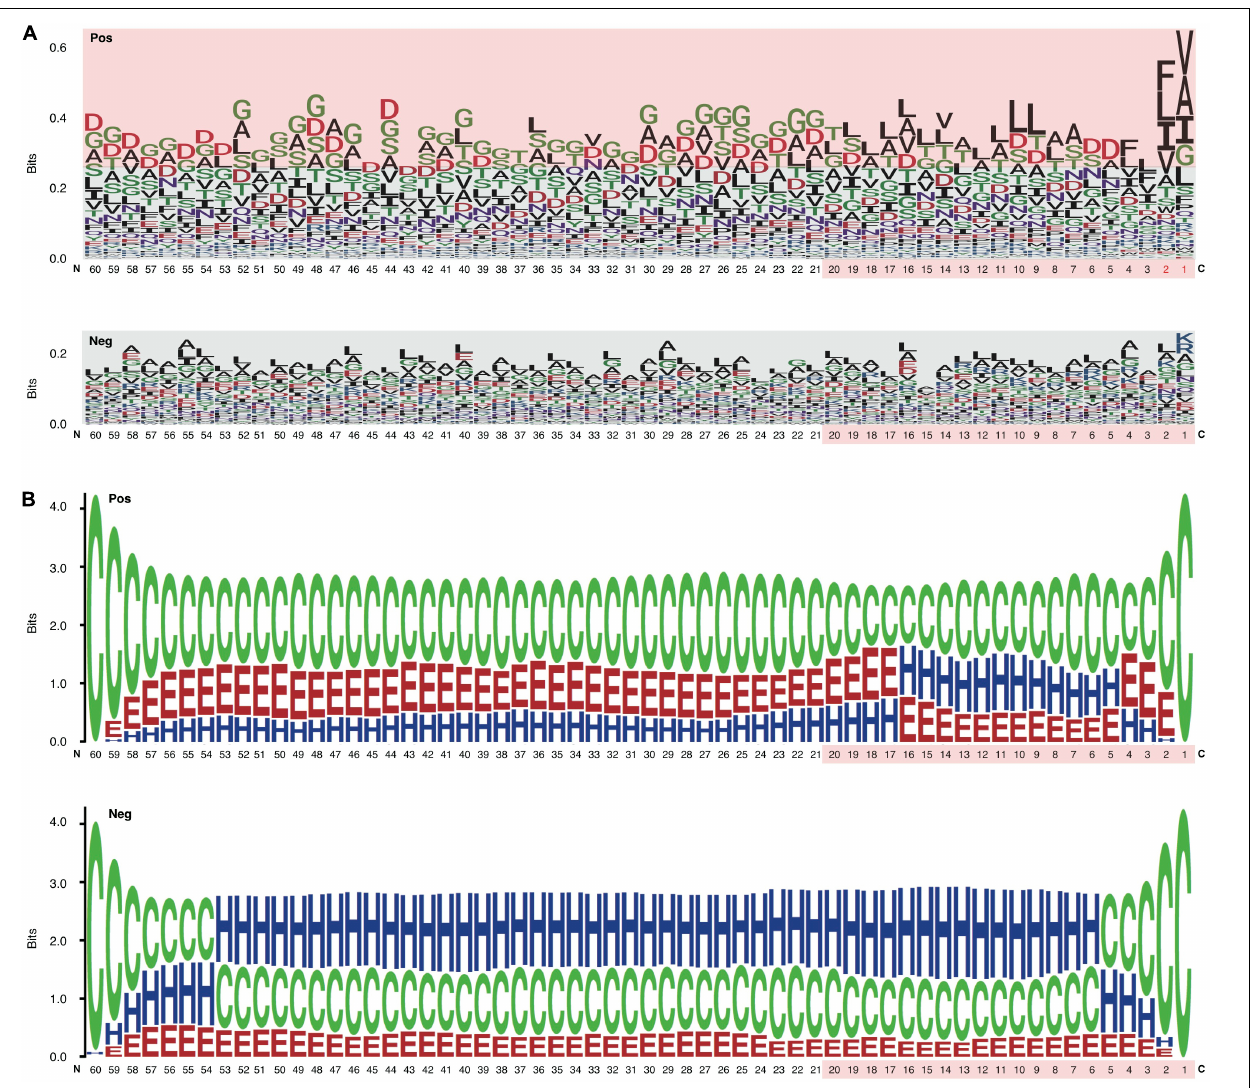
FIGURE 4 | Position-specific Aac and Sse profile difference between the C termini of RTX and non-RTX proteins. (A) Position-specific Aac profile of RTX and non-RTX proteins at C-terminal 60 positions. The strikingly specific bias Aac preference profile of RTX proteins with C termini and the C-terminal 20 positions of both RTX and non-RTX proteins are shown with pink background. The endmost C-terminal two positions with most typical sequence patterns are shown in red. (B) Position-specific Sse profile of RTX and non-RTX proteins at C-terminal 60